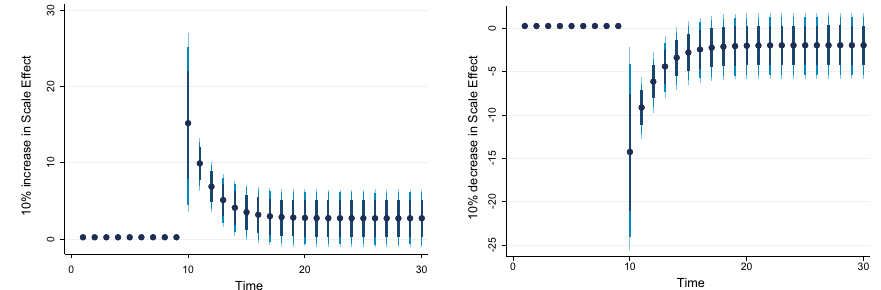
prediction value. The dark blue to light blue line shows 75, 90, and 95% confidence interval,